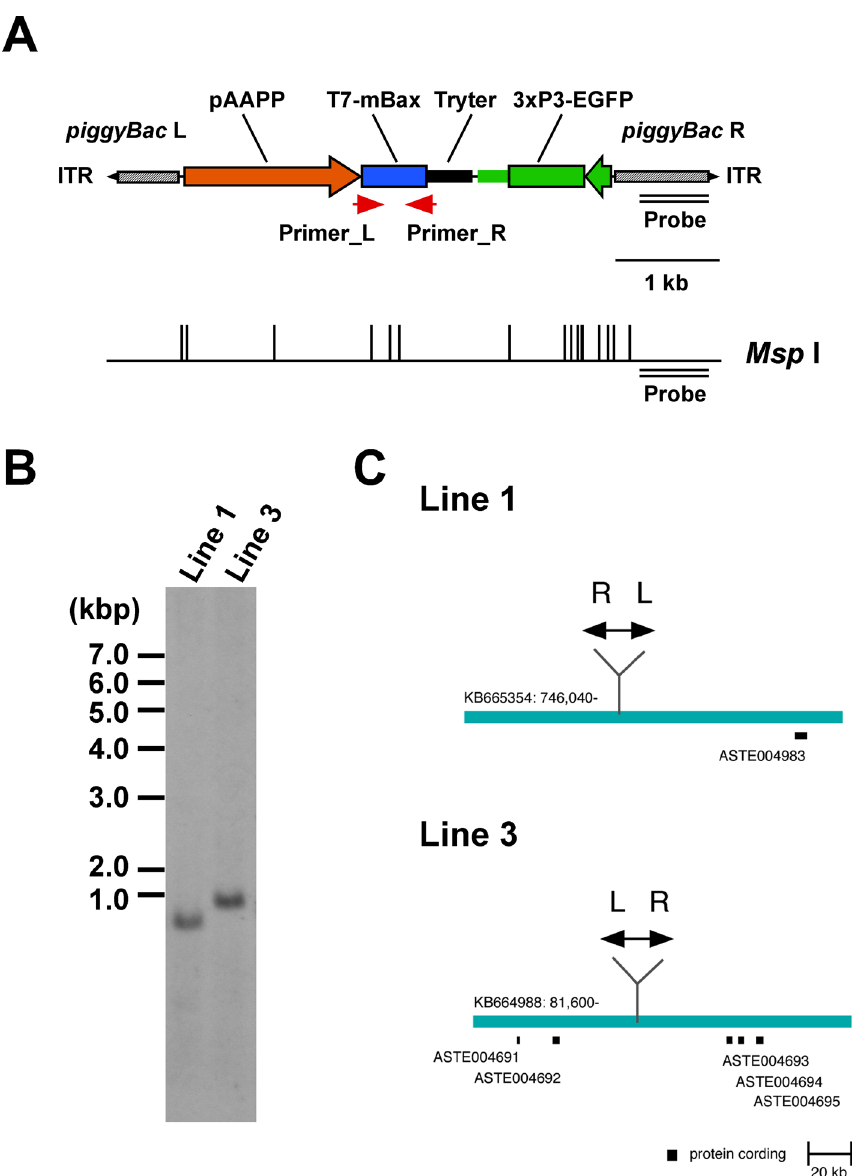
Fig 1. The gene structure of the piggyBac transformation vector, pBac[pAAPP-mBax; 3xP3-EGFP], TG mosquito lines, and insertion sites. (A) The gene construct derived from the piggyBac -based vector contains piggyBac Left-arm (L) and Right-arm (R) with an inverted terminal repeat (ITR). The T7-mBax gene is expressed under the control of the An . stephensi aapp promoter (pAAPP) and An . gambiae trypsin terminator (Tryter). The transformation marker, EGFP is expressed under the control of the 3xP3 promoter. A double line represents the probe region for a Southern blot analysis. The restriction enzyme ( Msp I) site is represented below the scheme. The red arrow represents the primer sites for a RT-PCR analysis in Fig 2. (B) A Southern blot analysis of AAPP-mBax lines. Genomic DNA from AAPP-mBax mosquito lines (lines 1 and 3) was digested with Msp I, and hybridized with a fragment corresponding to the piggyBac R region. (C) Insertion sites of the transgene in AAPP-mBax lines 1 and 3. The blue bars show the local DNA region within each genomic scaffold. Black boxes represent the annotated protein-coding region in the VectorBase (https:// www.vectorbase.org/). Double-headed arrows show the piggyBac construct. L: piggyBac Left-arm, R: piggyBac